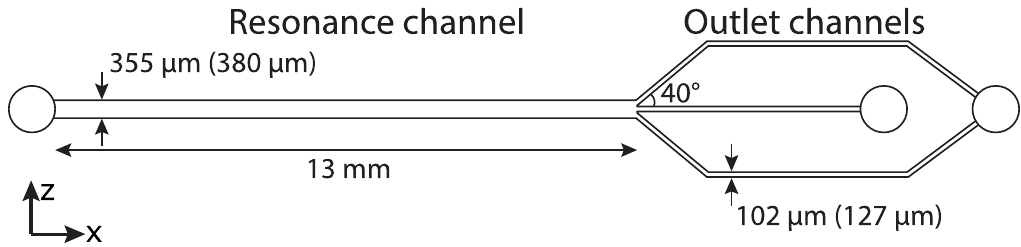
Figure 1. The design of the microfluidic chip. The first values are the values in the CAD drawing, where the values in brackets are the targeted values.